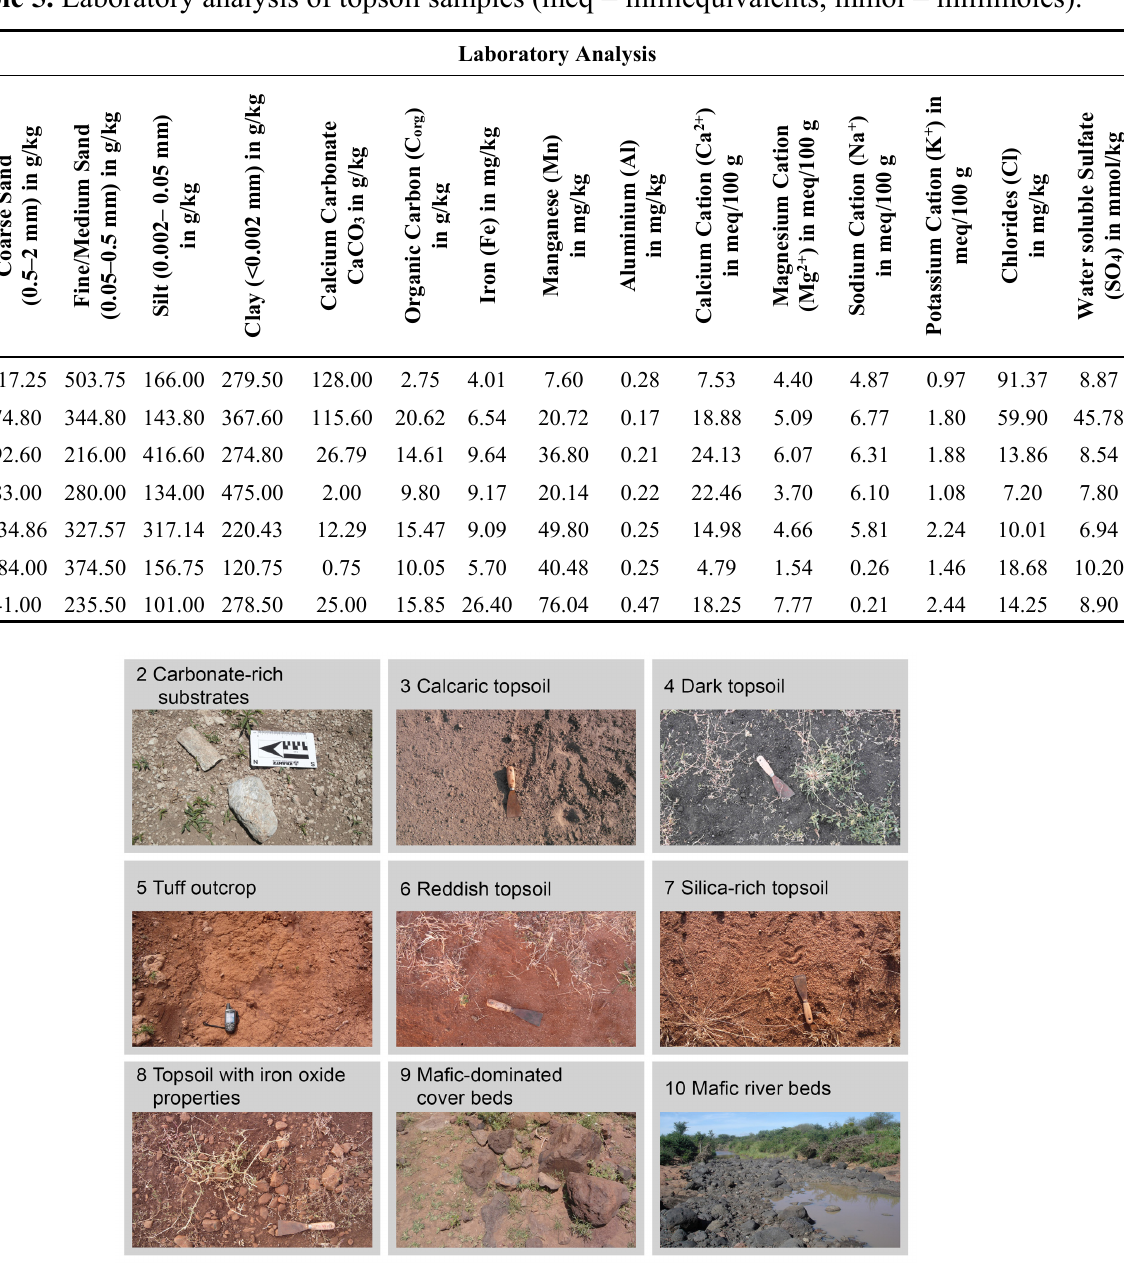
Figure 3. Target classes identified by field surveys and laboratory analysis (Class 1 =